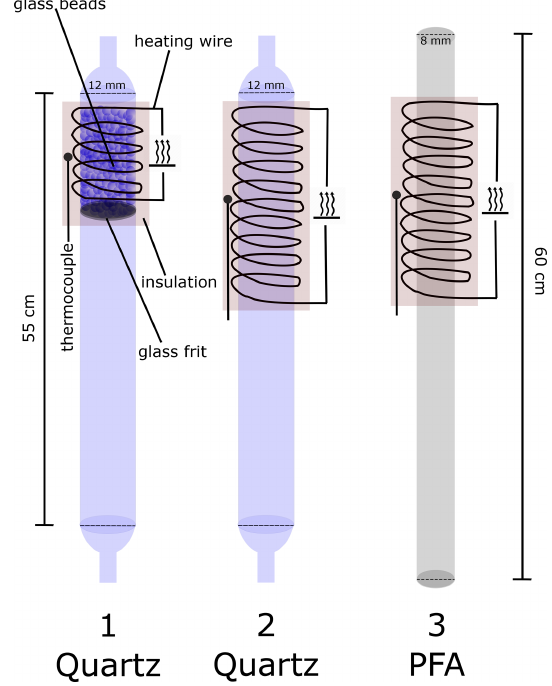
Figure 1. Schematic diagram of the thermal dissociation inlets TDI- 1, TDI-2 and